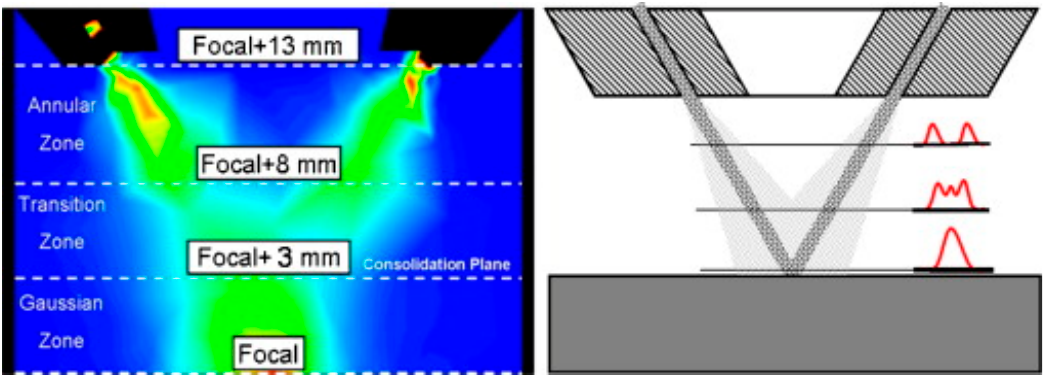
Figure 6. Evolution of powder flow distribution at different planes (reproduced with permission from [55]; Copyright © 2010 Elsevier).